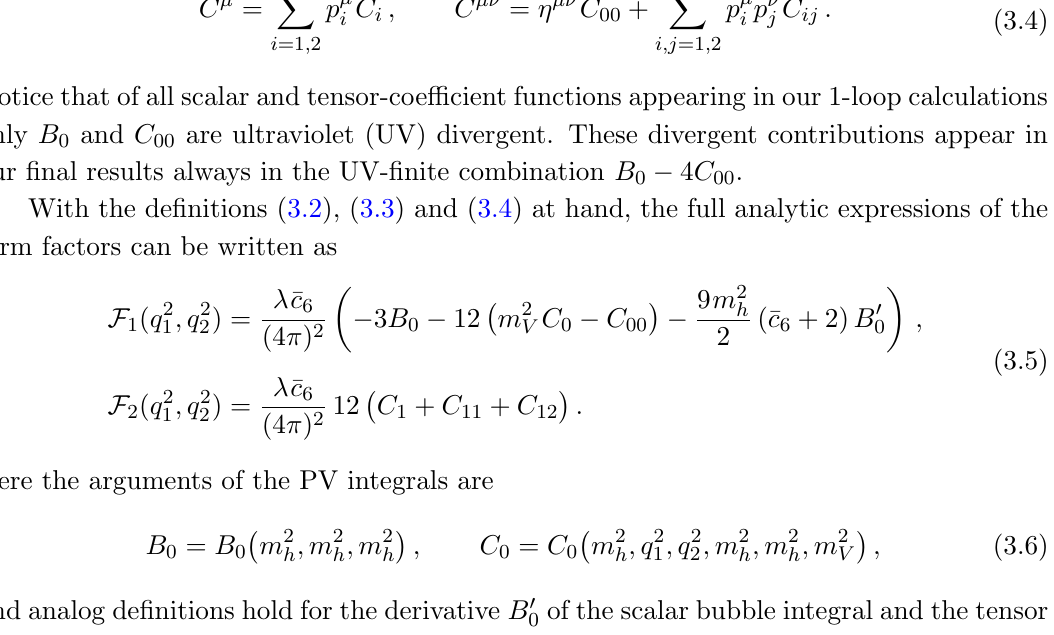
Figure 1 . The three 1-loop diagrams with an insertion of the e(cid:11)ective operator O to the V V h vertex at O ( (cid:21) ). Here (cid:30) denotes the relevant would-be Goldstone (cid:12)eld that needs to be included if the calculation is performed in a R (cid:24)